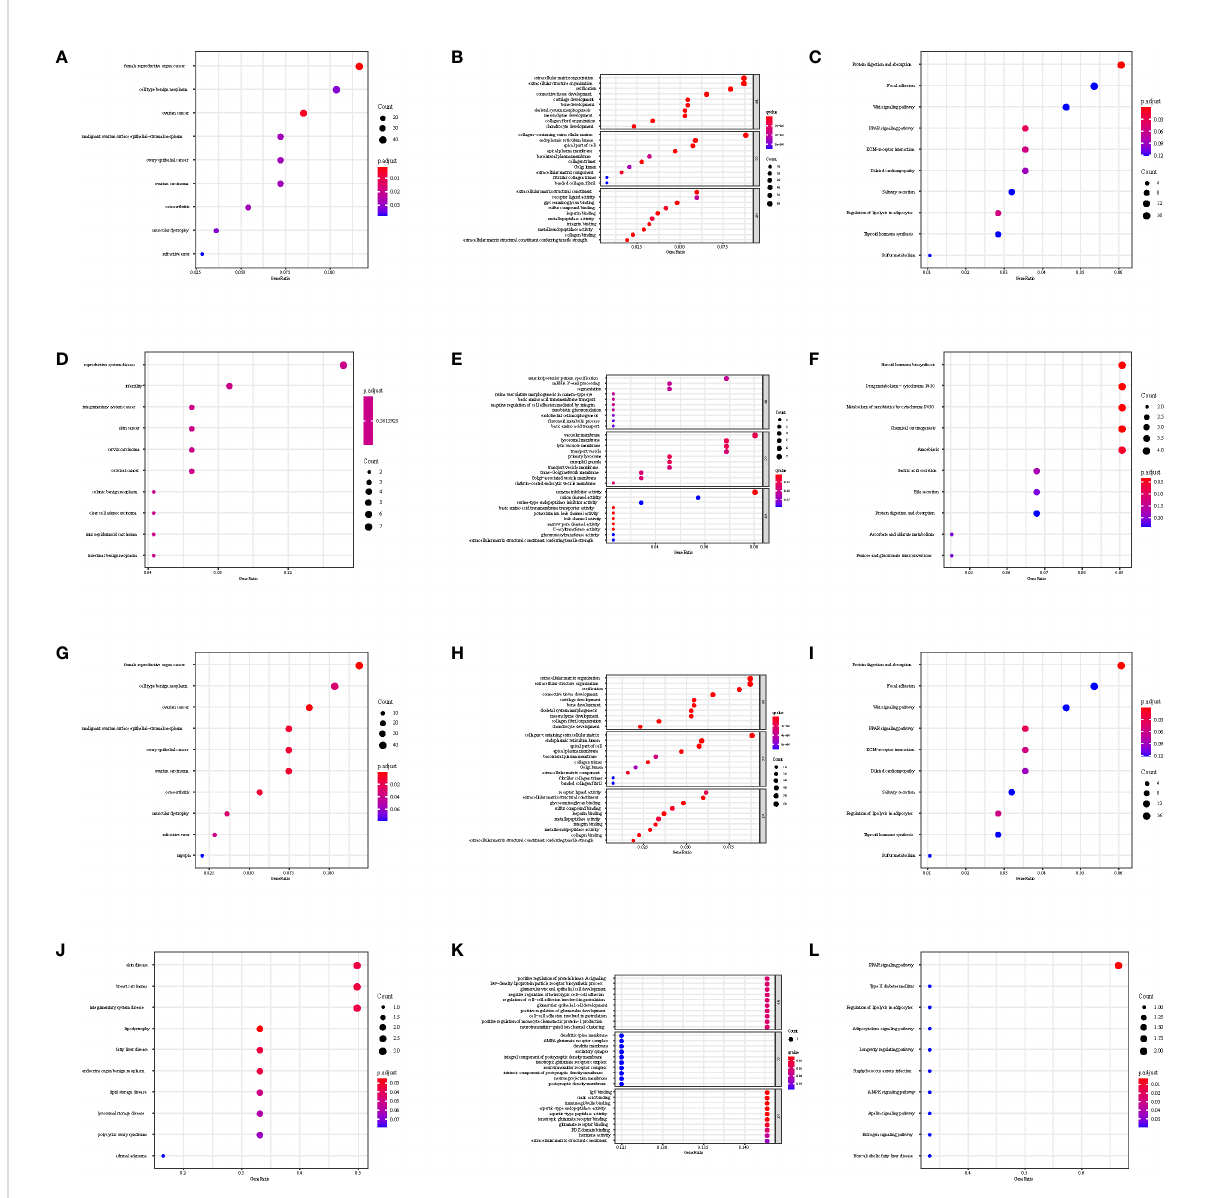
FIGURE 7 Disease Ontology, Gene Ontology, and Kyoto Encyclopedia of Genes and Genomes functional analysis in GSE92566. (A – C) DKK1, (D – F) JAG1, (G – I) LGR5, and (J – L)